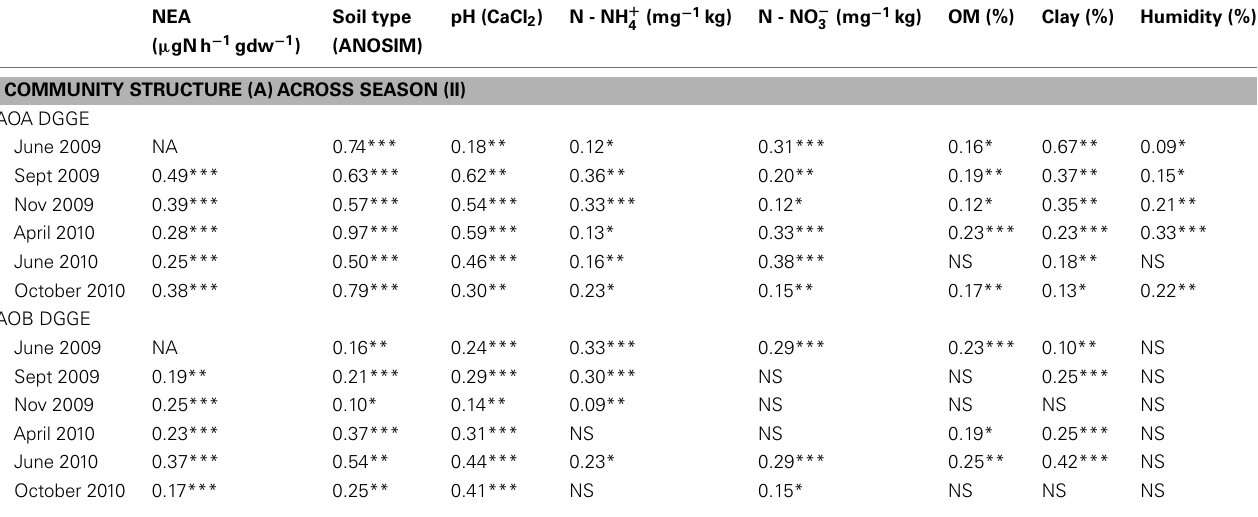
TableA3 | Correlations between the similarity matrices of community structureAOA andAOB, soil chemical parameters (pH, N - NH + OM %, clay content % and water content %) and NEA (relate analysis; NEA from September 2009 to October 2010) obtained with Primer-E (BEST test), for all sampling